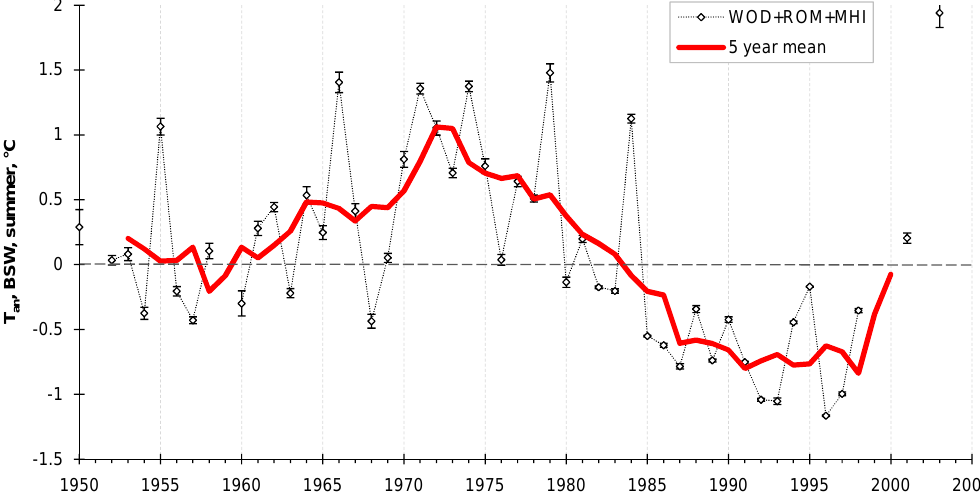
Fig. 7. Long-term time series of the temperature anomaly ( ◦ C) of BSW calculated from the combined WOD+ROM+MHI dataset for the warm period (May–November) in 1950–2004 (dotted line) and the 5-yr running mean (red line). Error bars show the standard error of the mean. See Fig. 8 for the number of stations available in each year.